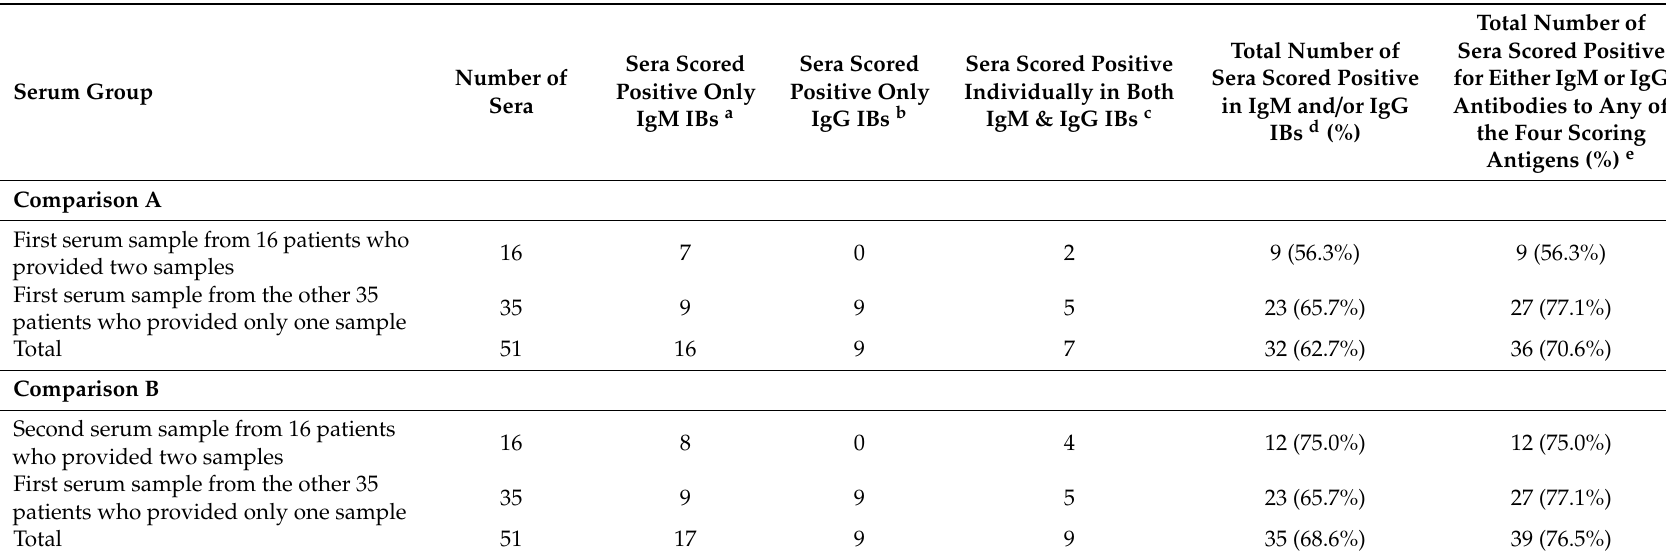
Table 2. TBRF IB results with sera from 51 patients positive by qPCR for